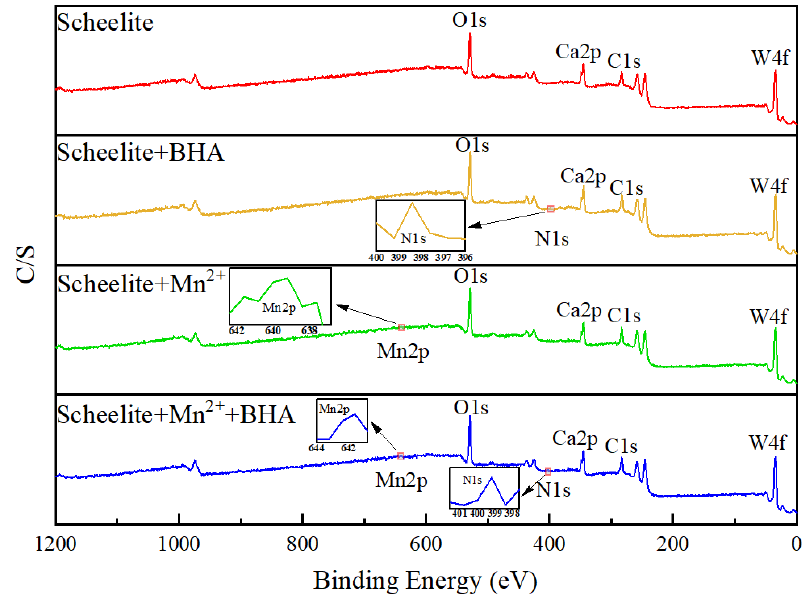
Figure 8. XPS spectra of scheelite treated with different conditions.